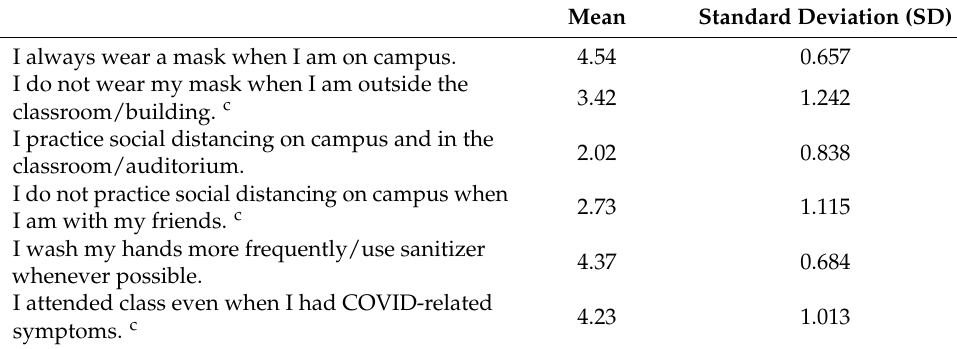
Table 7. Students’ practices of protective measures